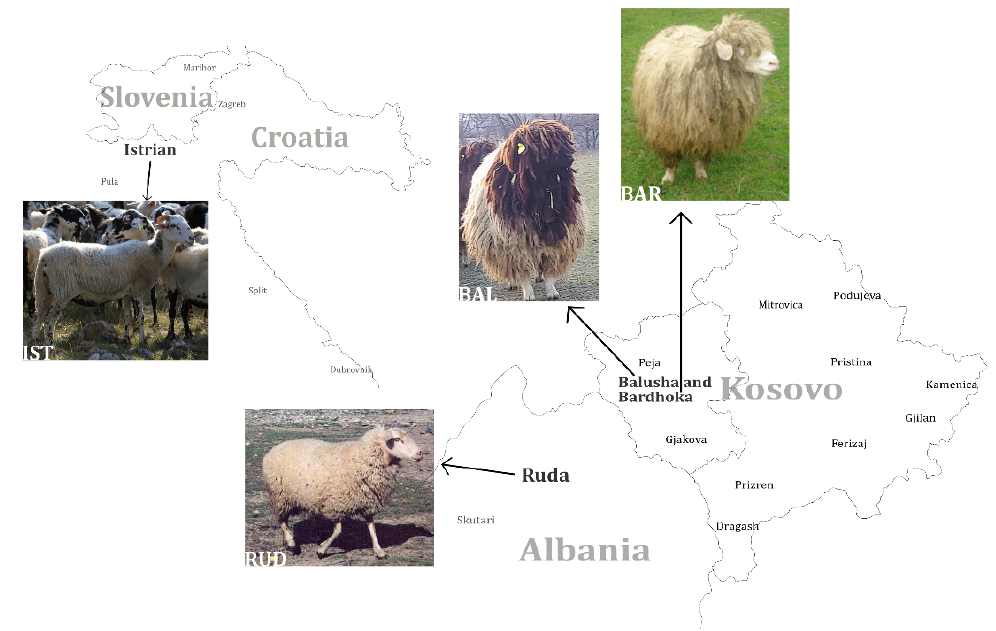
Figure 1. Geographic distribution of four analyzed sheep breeds in southeastern Europe. The black- headed Balusha (BAL), the white Bardhoka (BAR), originating from the same area in western Kosovo, the Albanian Ruda (RUD; photo: A. Hoda) and the Istrian Pramenka (IST; photo: V. Rezar), the latter one sampled in Slovenia. Please note that the proportions and distances of the map are not displayed realistically, they are only for orientation.